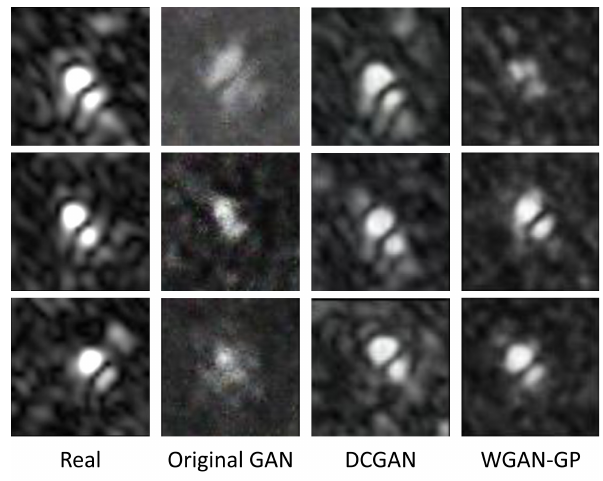
Figure 4. Generated images from the GANs under review. Classification TGB11.